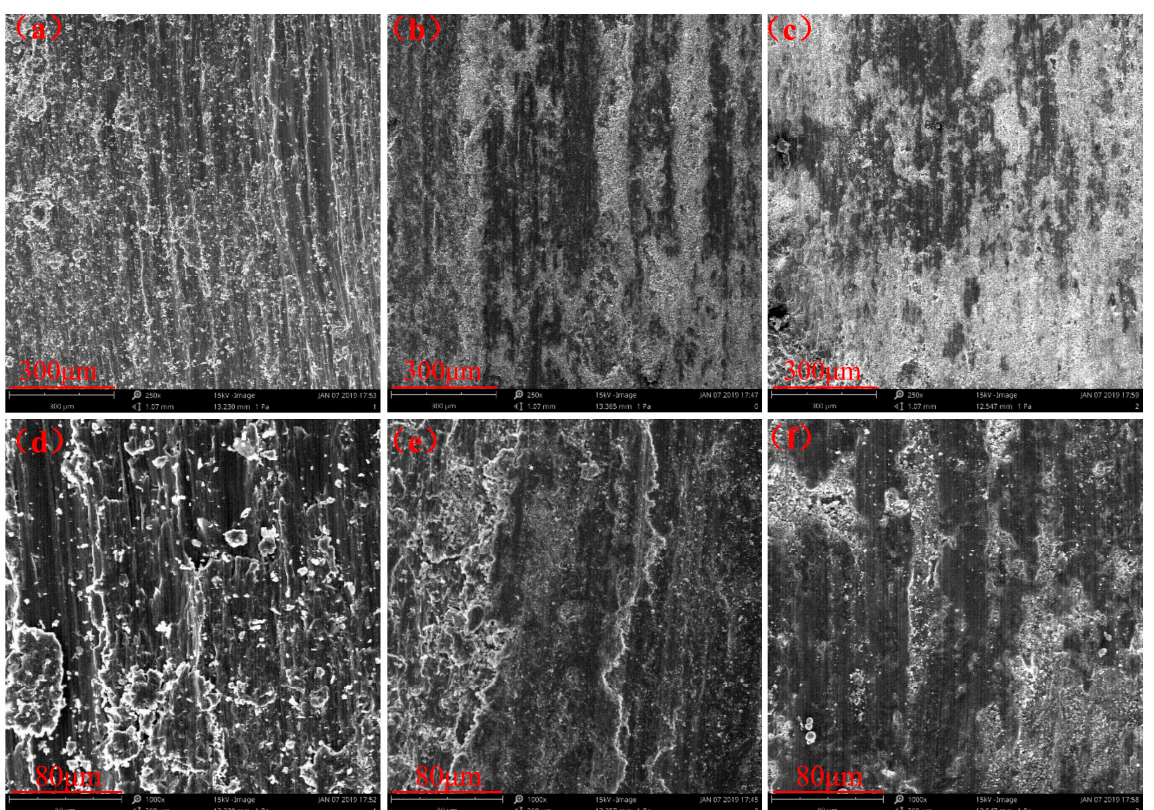
Figure 6. The wear scar morphology of cold-sprayed coatings of di ff erent powders: ( a , d ) A5001; ( b , e ) A0050; ( c,f ) 0082. ( b , e ) A0050; ( c , f )